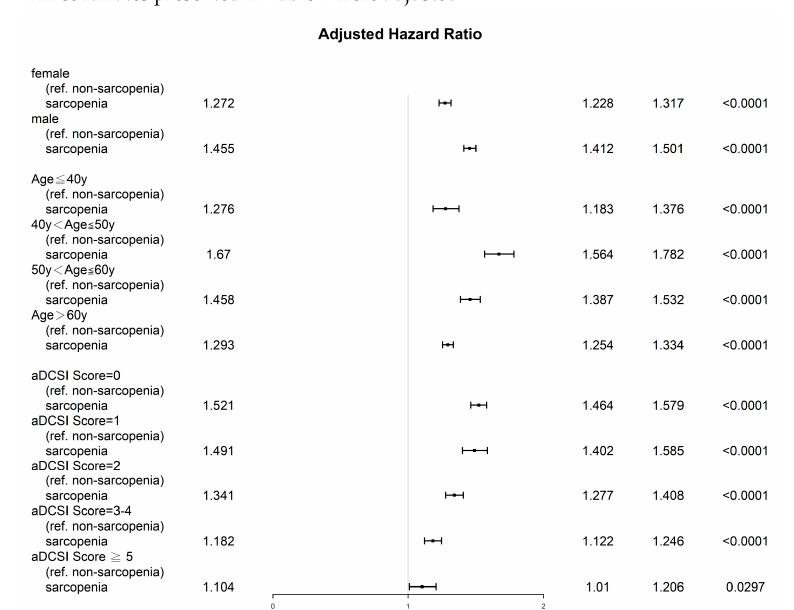
Figure 1. Sensitivity analysis of sex, age group, and adapted Diabetes Complications Severity Index scores performed using the inverse probability of treatment weighting for all-cause death in patients with diabetes with and without sarcopenia. Abbreviations: aHR, adjusted hazard ratio; y, years old; aDCSI, adapted Diabetes Complications Severity Index; CI, confidence interval; ref., reference group. All covariates presented in Table 2 were adjusted.